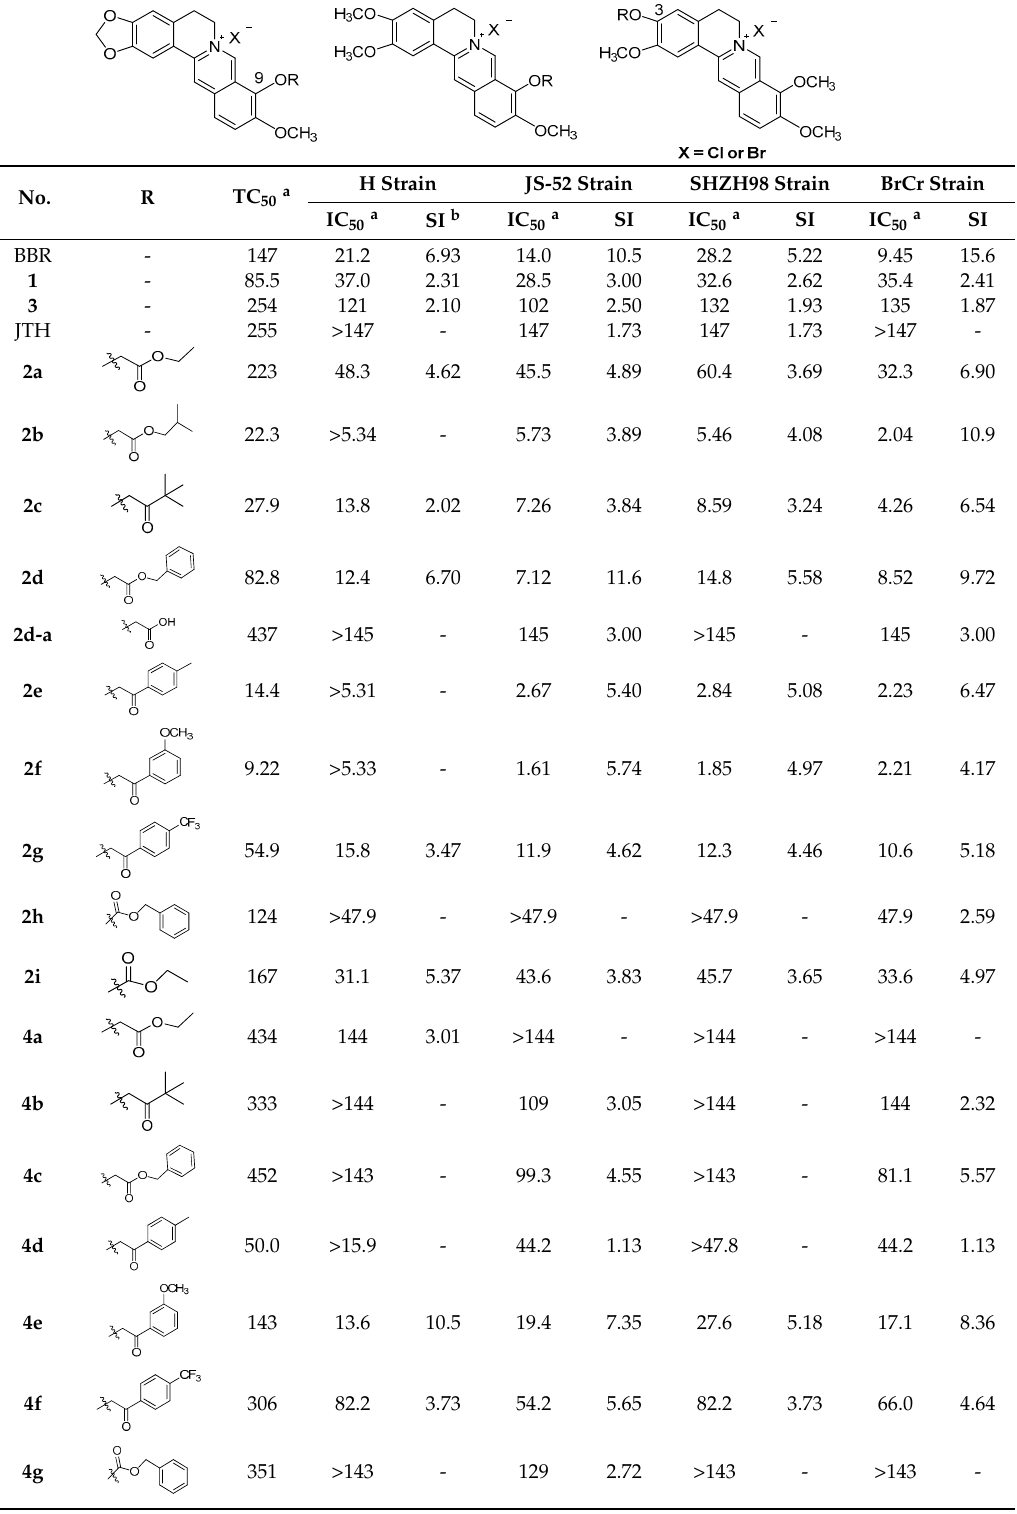
Table 1. SAR of all target compounds for anti-EV71 activity and cytotoxicity in Vero cells.